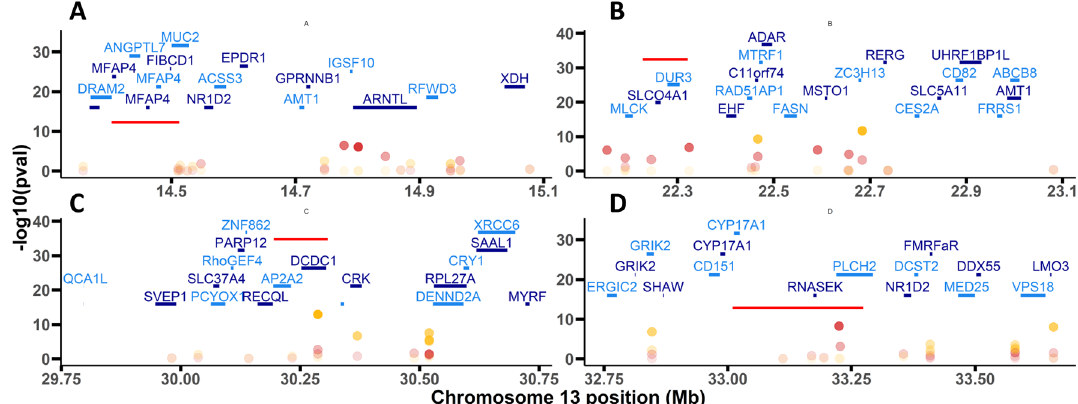
Figure 6. Manhattan plots for SNP significantly associated with color ( A , D ) and stripe pattern ( B , C ) phenotypes in four chromosome 13 subregions of C . edule based on the Mixed Linear Model (MLM). Y-axis represents − log 10 ( p -value) of the association with each SNP and X-axis its physical position in bp. Codes of genes mined in those regions are shown with underlined bars representing their length in Mb; yellow and red dots highlight associated SNPs with stripe and color, respectively; red bars at each plot show the most interesting candidates in the